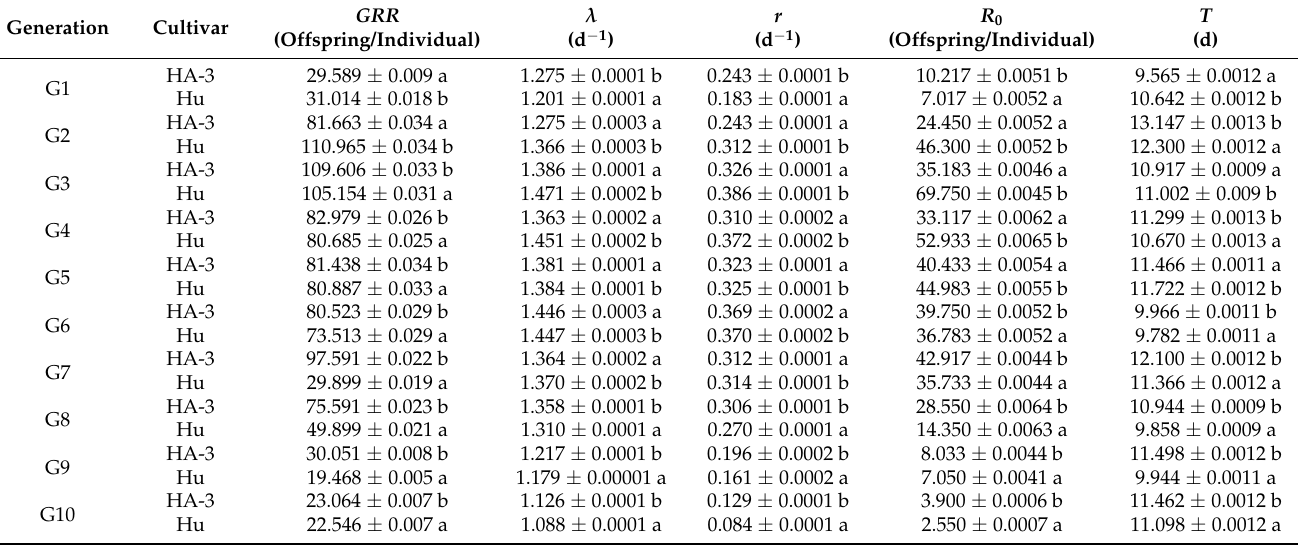
Table 5. Population parameters of SAA on HA-3 and Hu